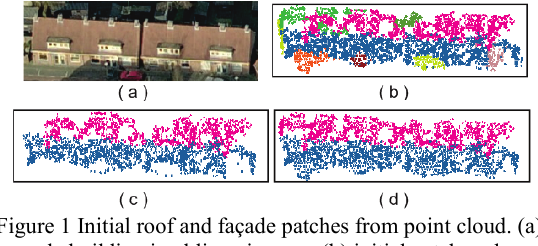
Figure 1 Initial roof and façade patches from point cloud. (a) sample building in oblique images; (b) initial patches above façade patches after surface growing; (c) grouped roof patches; (d) expanded roof patches. In (c) and (d), one colour indicates one group. Image © Blom